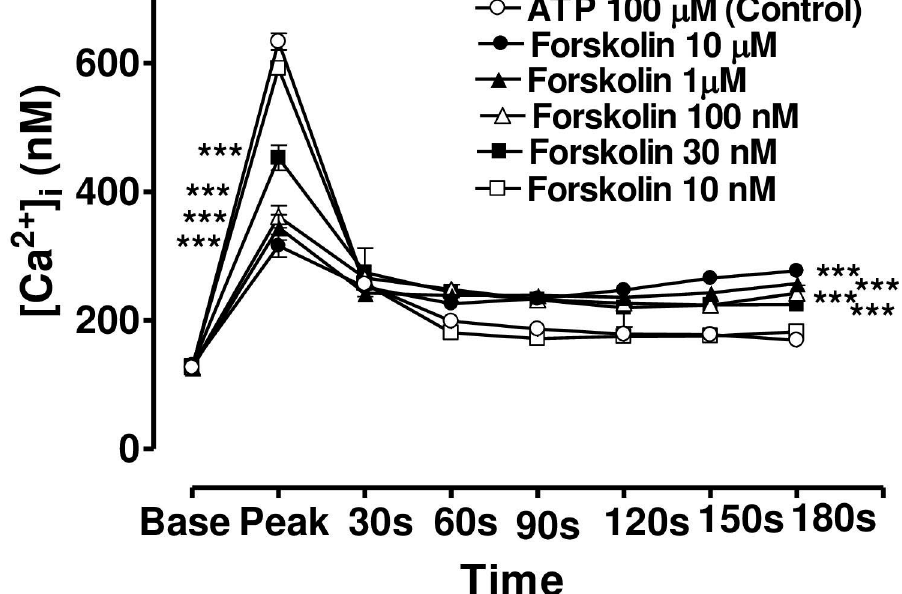
Fig 7. Effect of increasing concentration of forskolin on the Ca 2+ -mobilizing response of ATP (100 μ M) in bovine cultured CE, both at the peak of the Ca 2+ transient and at selected time intervals thereafter. Cultured cells were incubated for 6 min with appropriate concentration of forskolin in HEPES buffered Krebs’ solution containing 1.8mM calcium. The cells were then exposed to 100 μ M of ATP. Each point represents a mean ± s.e.mean of 8–15 experiments. Significance of differences between incubations with or without forskolin; �� p < 0.01 and ��� p < 0.001, Bonferroni’s multiple comparison test. Base value indicates the [Ca 2+ ] i prior to addition of ATP.